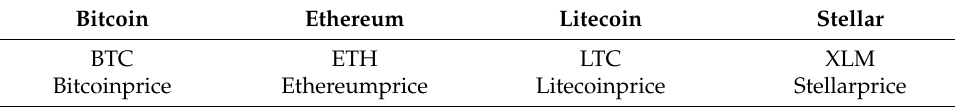
Table 1. Example Hashtags.